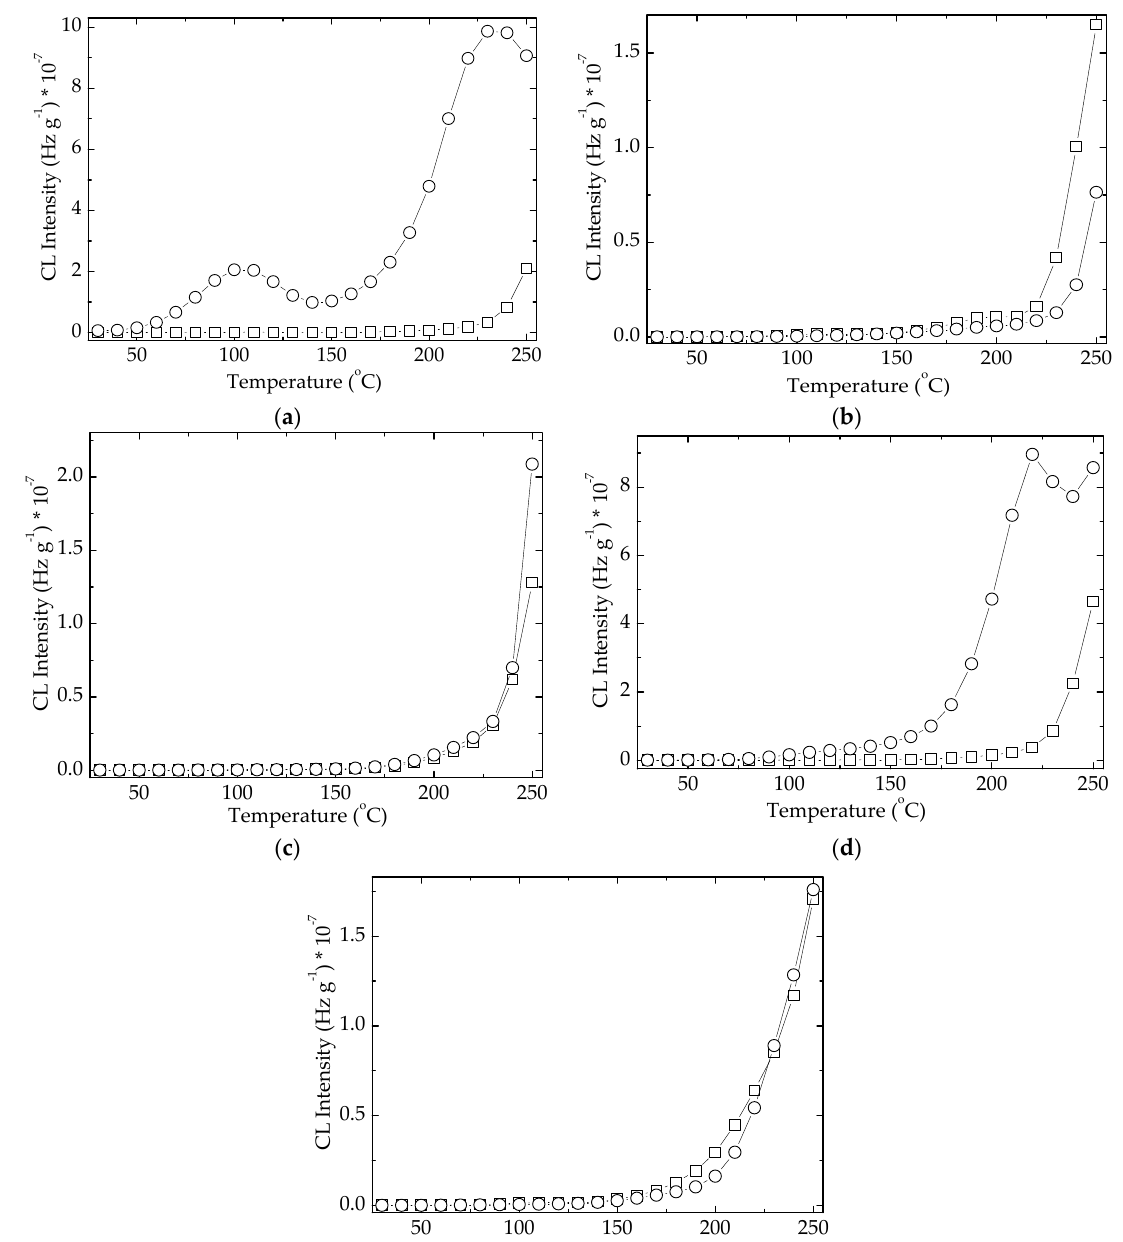
Figure 7. The comparison of nonisothermal CL spectra belonging to various compositions of EPDM samples. ( a ) neat EPDM; ( b ) EPDM/POSS 1 phr; ( c ) EPDM/POSS 3 phr; ( d ) EPDM/POSS 5 phr; ( e ) EPDM/RM (square) dose 0 kGy; (circle) dose 50 kGy. Heating rate: 10 °C min − 1 .